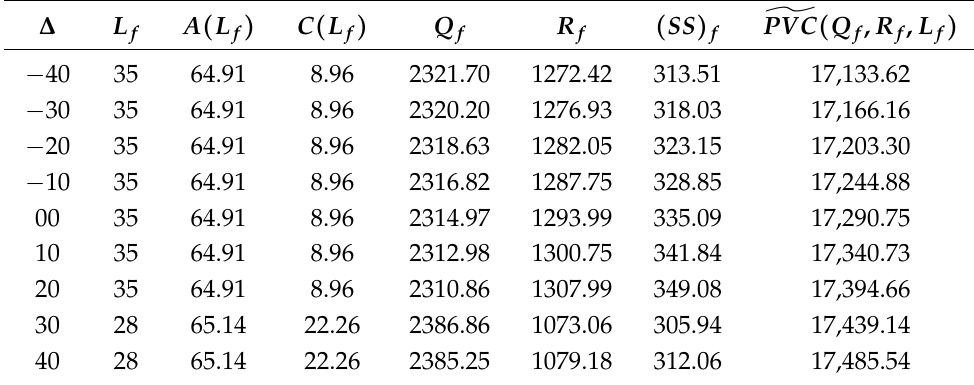
Table 11. Effect of ∆ in the fuzzy stochastic